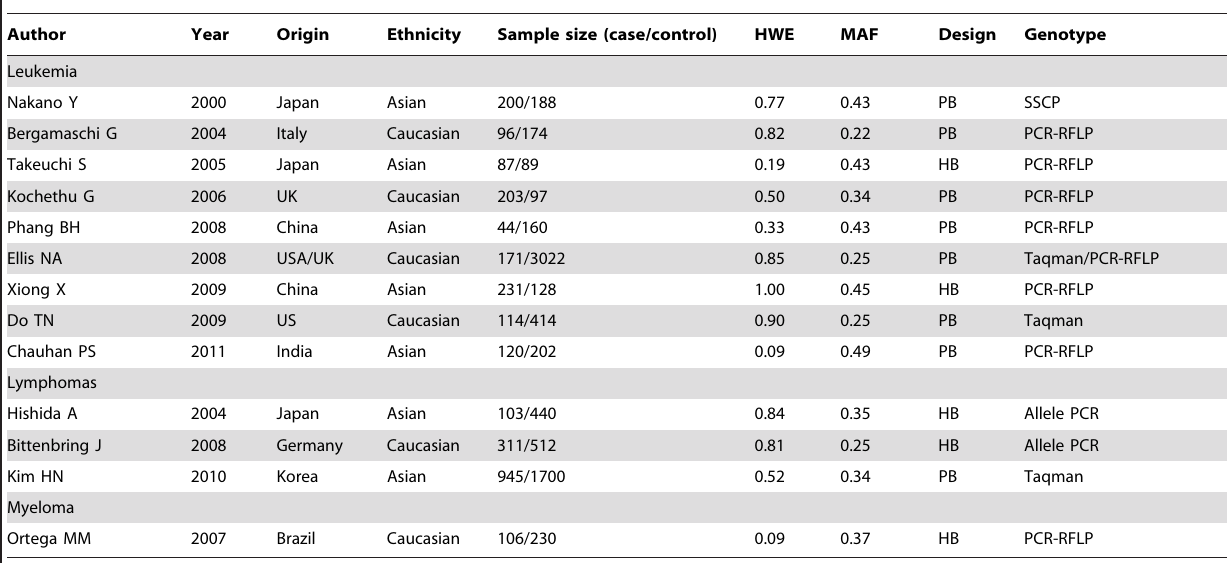
Table 1. Characteristics of literatures included in the